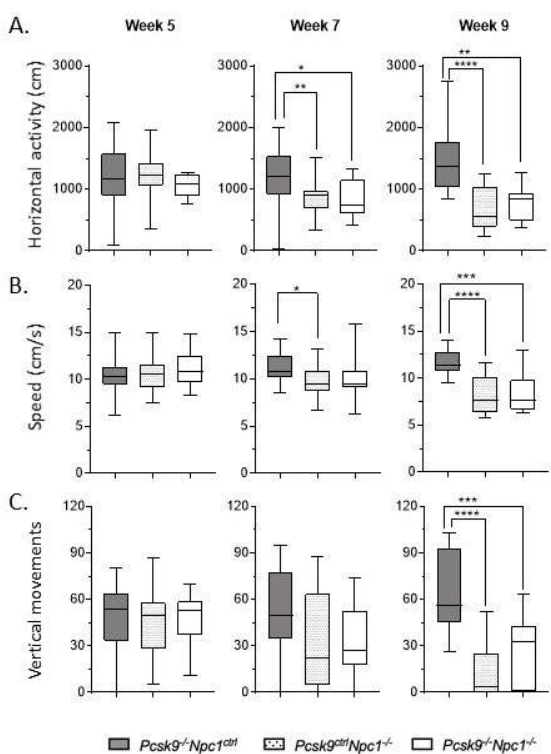
Figure 2. Motor coordination in Pcsk9 - / - mice in the context of NPC1 disease. Using the AccuScan activity box, the horizontal activity ( A ), walking speed ( B ), and vertical activity ( C ) of the mice were recorded on a weekly basis. Results from 5, 7 and 9 weeks are plotted here. As expected, Pcsk9 - / - / Npc1 ctrl showed consistent measurements of all activity across all timepoints. In contrast, Pcsk9 ctrl / Npc1 - / - and Pcsk9 - / - / Npc1 - / - groups displayed decreased horizontal activity and walking speed starting at week 7, which was worse and more significant at 9 weeks. The average number of vertical movements of both Pcsk9 ctrl / Npc1 - / - and Pcsk9 - / - / Npc1 - / - groups was significantly decreased by week 9. Asterix indicate significance levels, * p < 0.05; ** p < 0.01; *** p < 0.001; **** p <